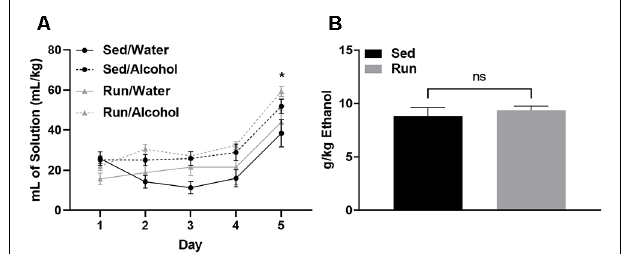
FIGURE 2 | Ethanol consumption during the drinking in the dark protocol. Comparison between the average amount of fluid ingested ( ± SEM) over the 5-day DID procedure (relative to body mass) for mice that had access to alcohol and water (A) and total ethanol intake (relative to body mass) during the final DID session (B) . * P < 0.05 Main effect of day, ns P > 0.05 between Run/Alcohol and Sed/Alcohol. Data represent means ± SEM.